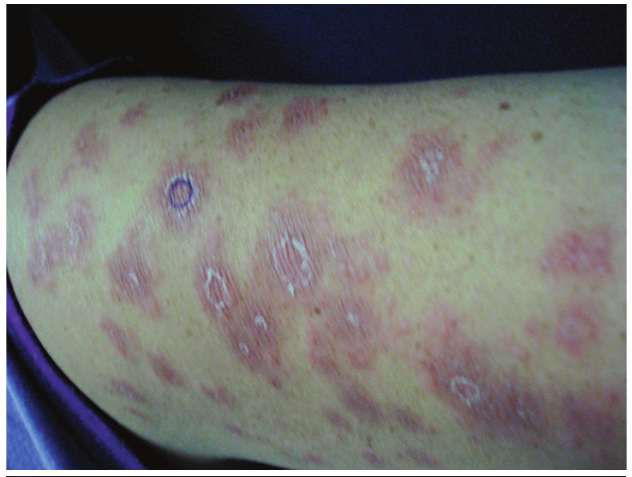
figurE 1 − Clinical aspect of patient with metastatic cutaneous Crohn’s disease: erythematous scaly plates in left arm